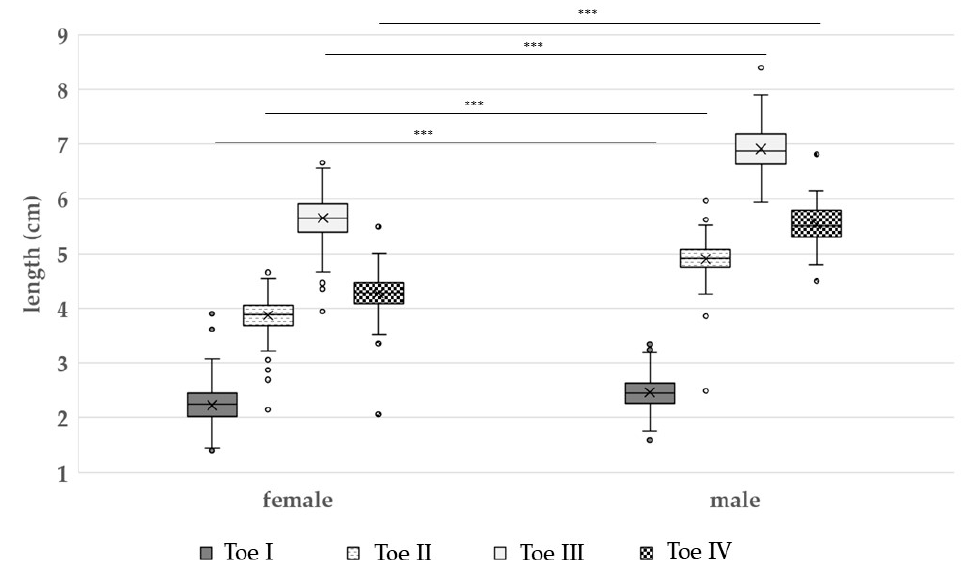
Figure 3. The lengths (cm) of toe I, II, III, and IV among female and male broiler breeders ( n = 656 feet in total). Results are presented as boxplots (data range, median, lower quartile and upper quartile; outliers are included in the graph as dots and means as crosses). Significant effects between toe length of females and males are apparent in toe I, II, and III. *** = p < 0.05